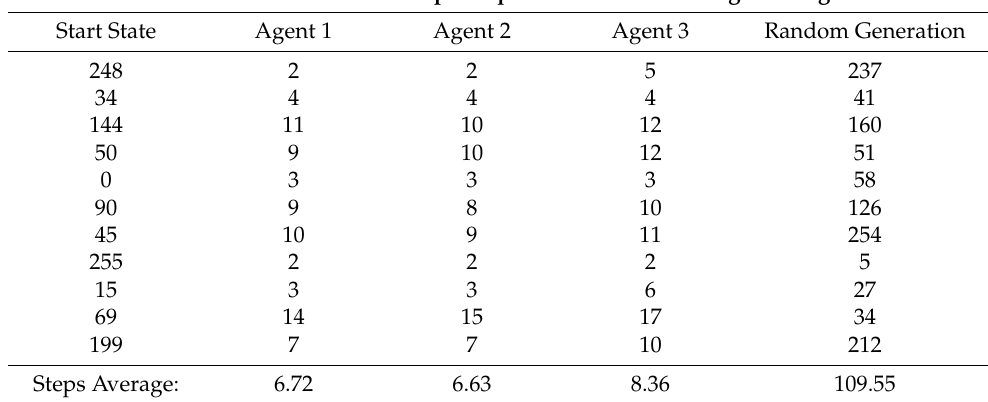
Table 3. Performance comparison between trained agents with a similar configuration and the untrained agent (visible in the random generation column).